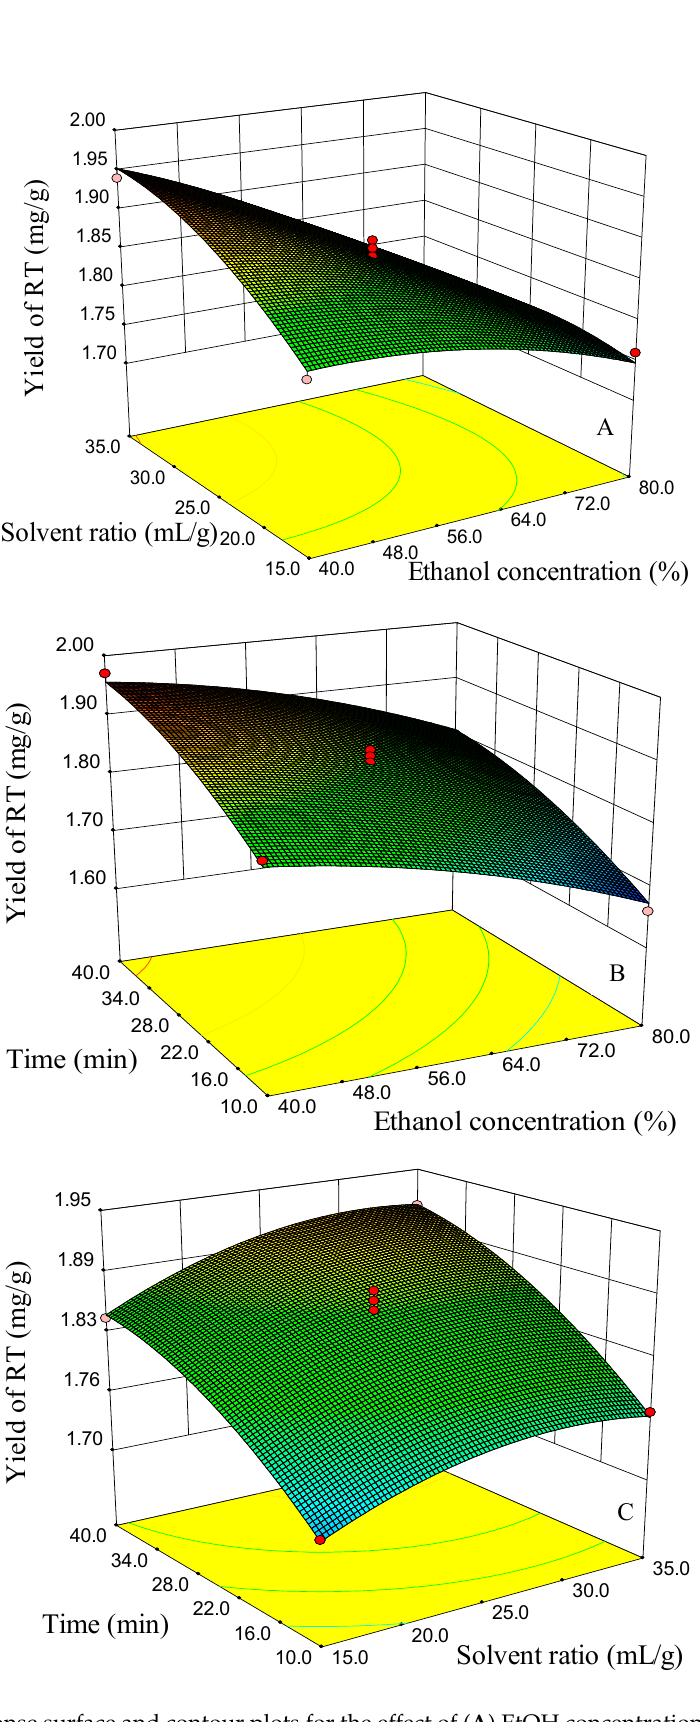
Figure 9. Response surface and contour plots for the effect of ( A ) EtOH concentration/solvent ratio, ( B ) EtOH concentration/time and ( C ) time/solvent ratio on the yields of rutin (RT).